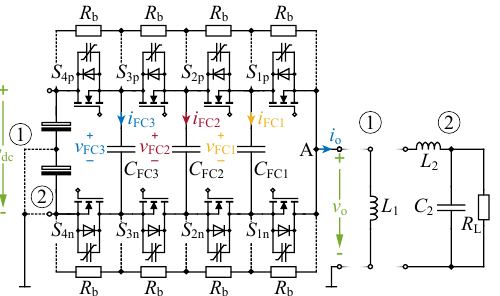
Figure 9. Schematic (cf. also Figure 1) of the 5L-FCC used in experiments with two configurations: 1 (cid:13) Split DC-link at the input and inductive load connected to the DC-link mid-point to obtain symmetrical currents; 2 (cid:13) full DC-link at the input and LC filter with resistive load in the output to achieve asymmetrical